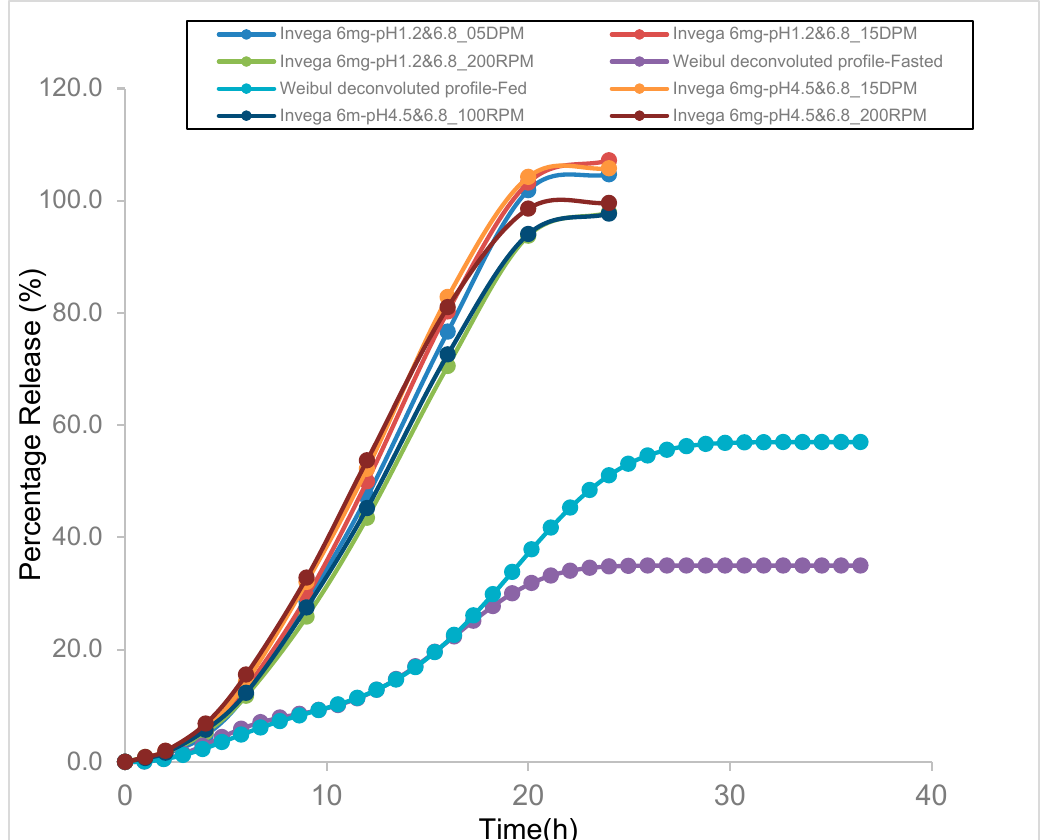
Figure 8. Percentage release (%) vs. time (h) of paliperidone ER OROS formulation (6 mg) in different fasting mimic dissolution media (pH 1.2 and pH 6.8) and fed mimic dissolution media (pH 4.5 and pH 6.8) under different conditions (5 or 15 dips per minute, 100 or 200 rotation per minute using BioDis